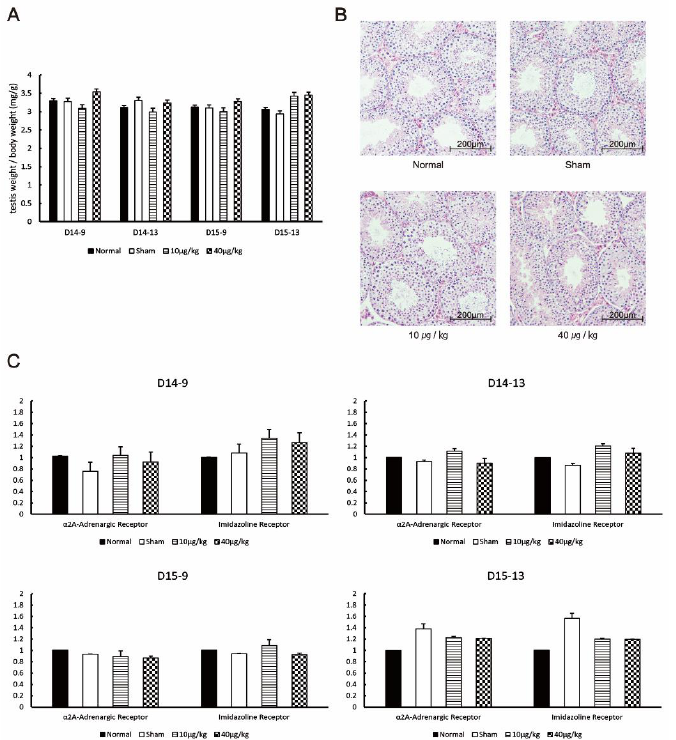
Figure 2. Effects of DEX administration on testicular morphology and receptors. ( A ) The testis weight/body weight ratio of the mice was compared at each testis collection point. ( B ) HE staining of mouse testis collected by D15-13. ( C ) The expression level s of α2A -adrenergic and imidazoline receptors at each testis collection period were measured by RT-PCR. The values in the graph are presented as means ± SDs. The sampling points after 14 days of continuous DEX administration were 9:00 on day 14 (D14-9), 13:00 on day 14 (D14-13), 9:00 on day 15 (D15-9), and 13:00 on day 15 (D15-13).